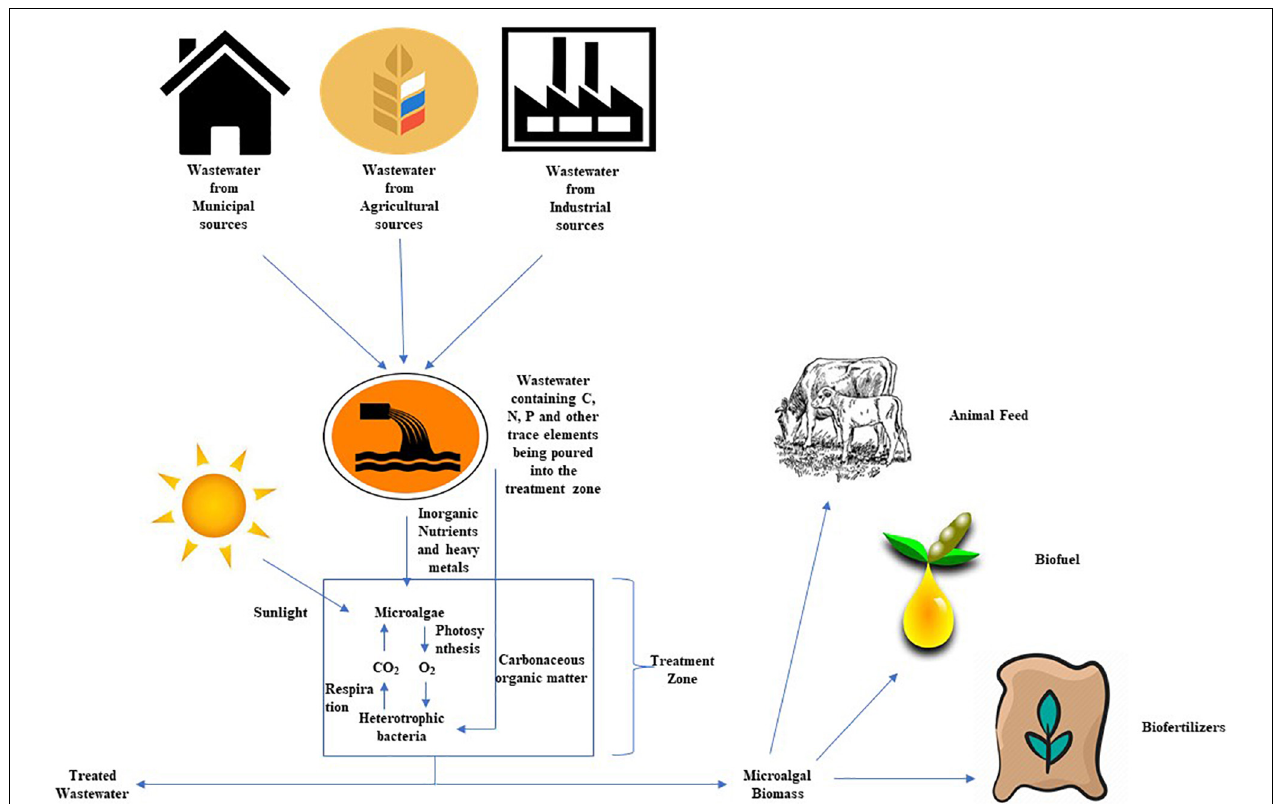
FIGURE 4 | Integrating algae and bacteria for the degradation of wastewater